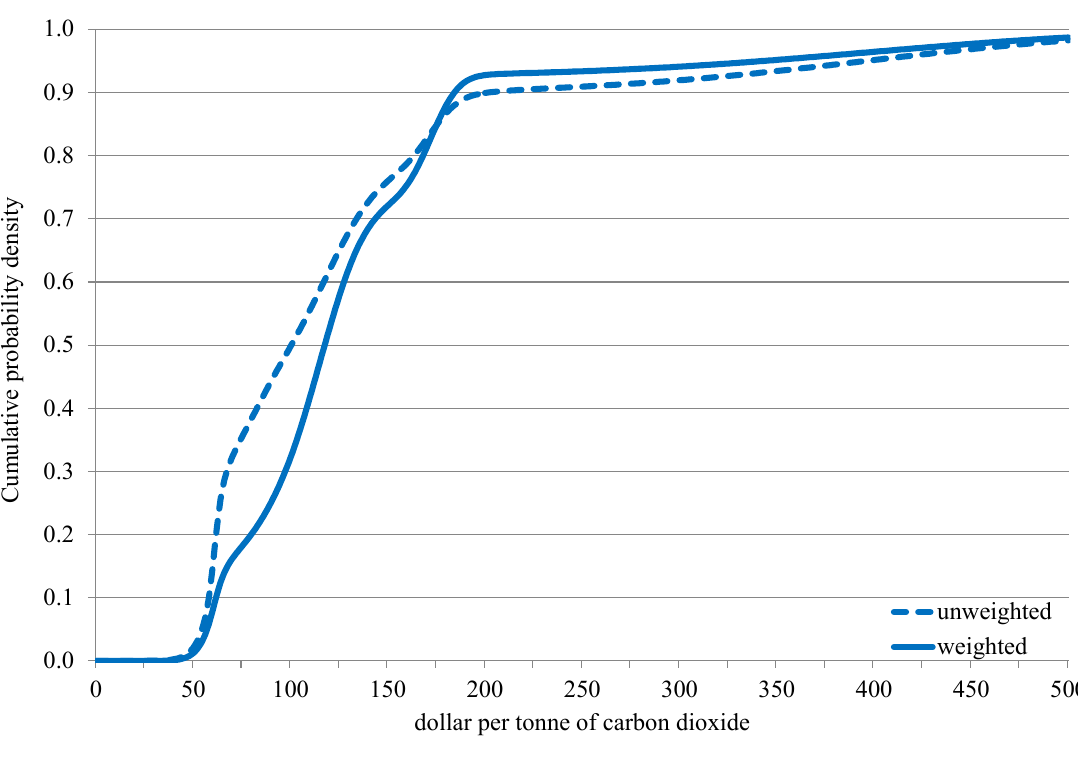
Figure 4. The cumulative density functions, weighted and unweighted, for a 40% emission reduction (from base year) in